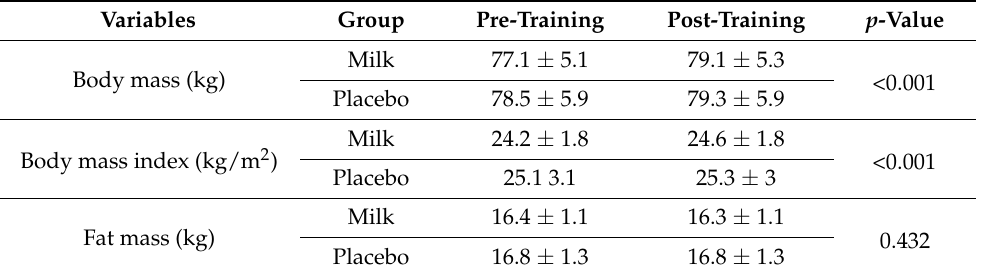
Table 4. Body composition characteristics (mean ±